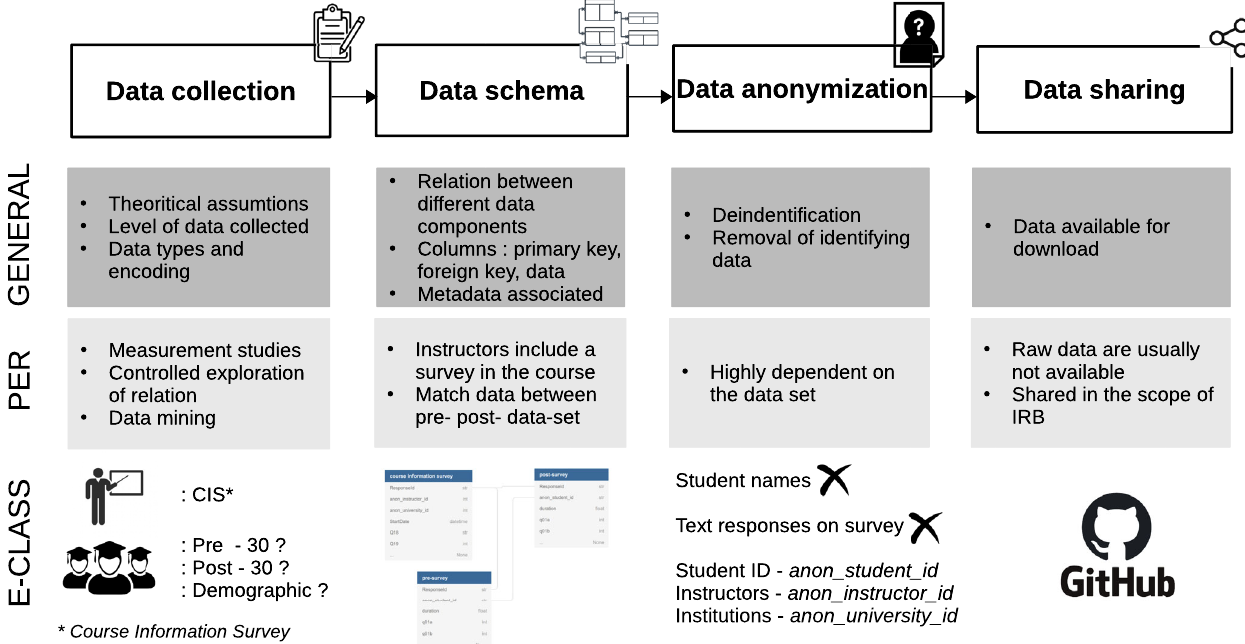
FIG. 1. A data-sharing model for PER. While data sharing occurs across all of science, PER has specific needs to make data sharing generally available, as does the E-CLASS